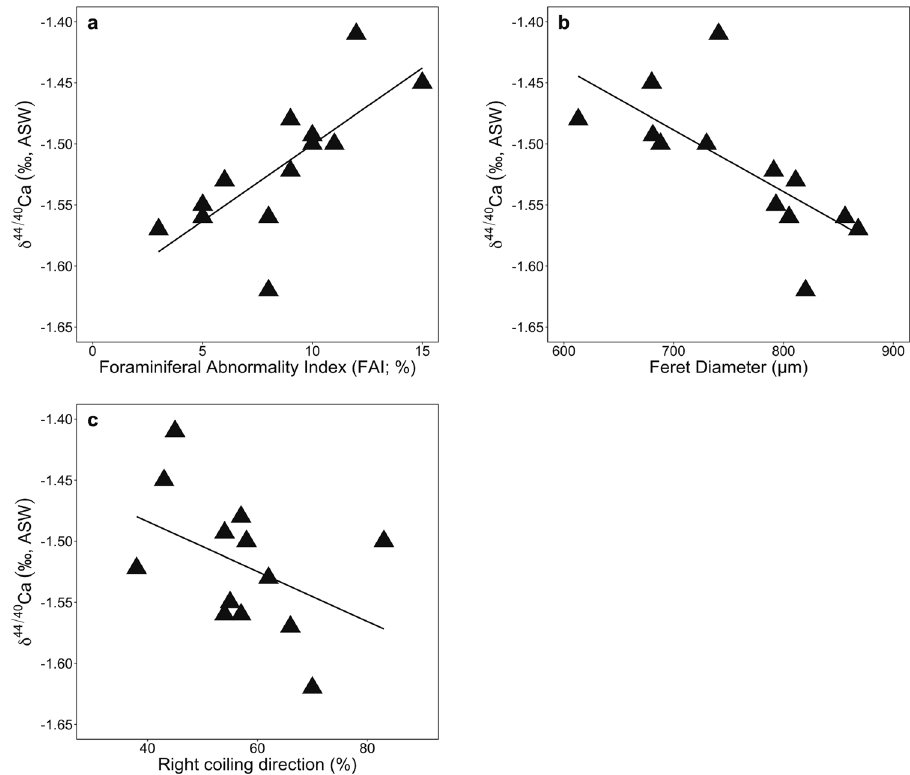
Fig. 2 Regression analyses of Bottaccione section δ 44/40 Ca values and morphometric data. Planktic foraminifera Rotalipora cushmani δ 44/40 Ca values across the lower critical interval (LCI) regressed against R. cushmani morphometric data published in Coccioni et al. 18 shown in black triangles, including a Foraminiferal Abnormality Index or FAI, b Feret Diameter, and c Right coiling direction. Statistically signi fi cant relationships shown by black lines are observed between δ 44/40 Ca and FAI ( p = 0.004, R 2 = 0.50), as well as δ 44/40 Ca and Feret Diameter ( p = 0.006, R 2 = 0.45); however, the weak negative relationship between δ 44/40 Ca and right coiled specimens is not signi fi cant ( p = 0.14, R 2 = 0.11). ASW Atlantic